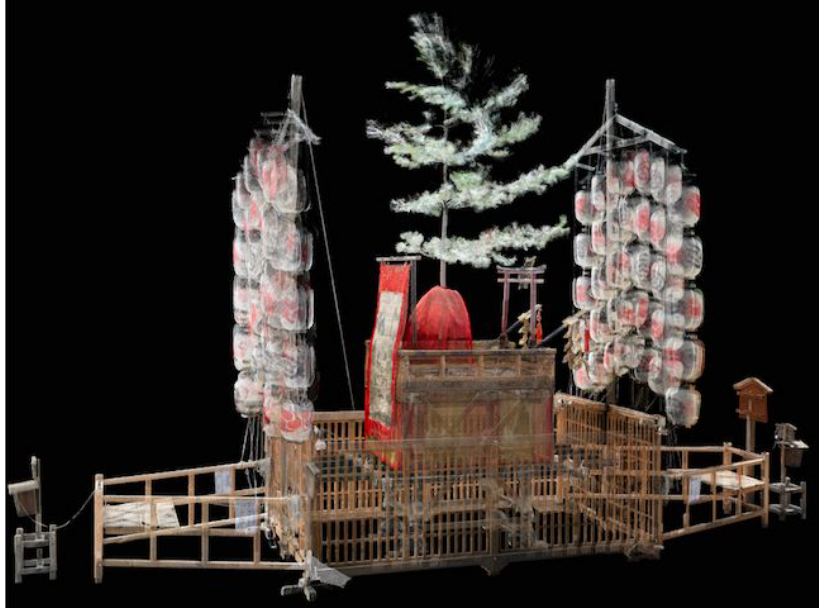
Figure 1. See-through imaging of a laser-scanned point cloud of the Hachiman-Yama float used in the Gion Festival Figures 1 and 2 show examples of the application of our proposed method to laser-scanned point clouds of festival floats with high cultural value. The festival float shown in Figure 1 is Hachiman- Yama , and the float presented in Figure 2 is Fune-Hoko . Both floats are used in the Gion Festival of Japan. A “Yama”-type float has a pine tree on its roof.